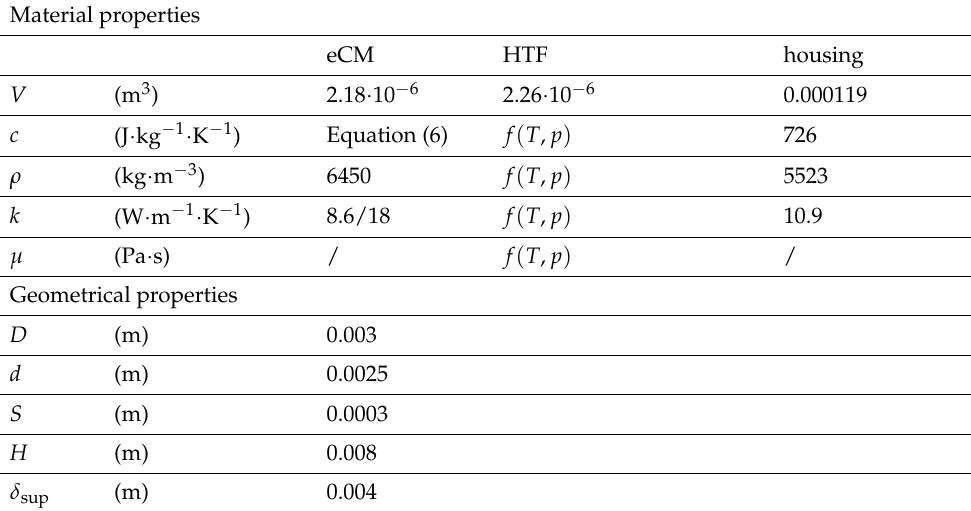
Table A1. Input parameters to the numerical